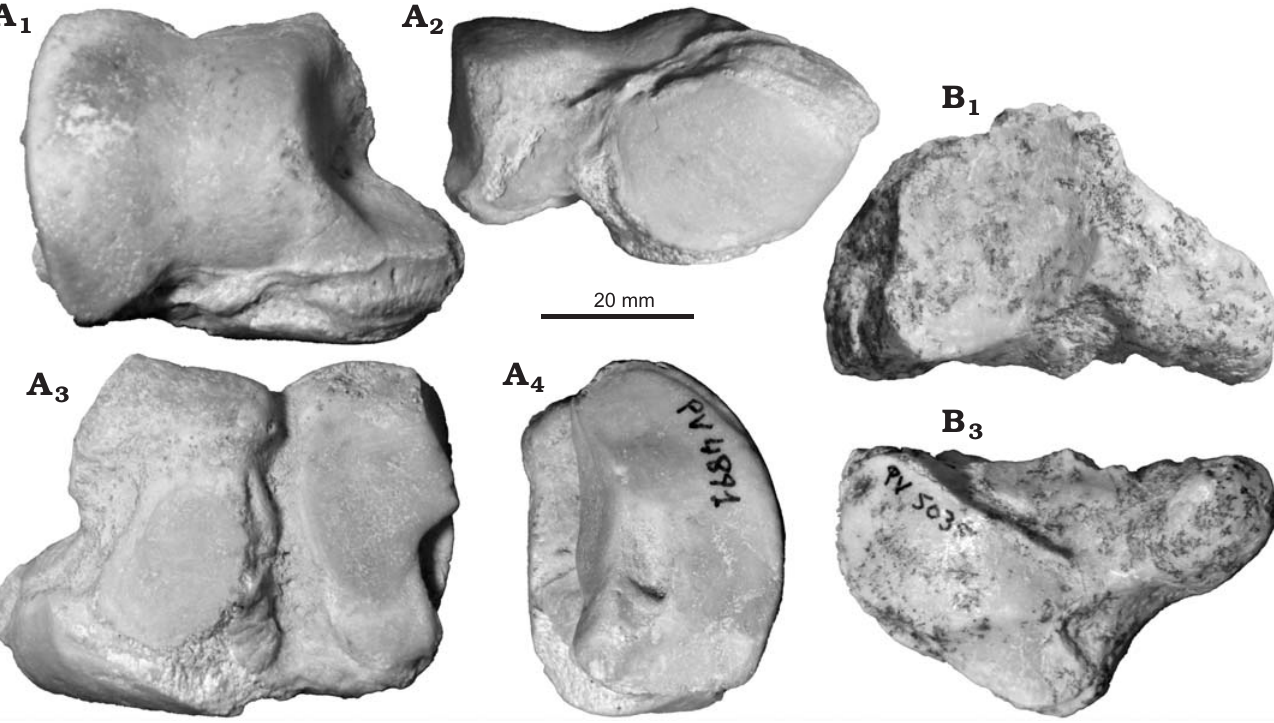
Fig. 6. Tarsal bones of leontiniid notoungulate Gualta cuyana Cerdeño and Vera, 2015 from Quebrada Fiera, Mendoza, Argentina; Deseadan SALMA (late Oligocene). A . MCNAM-PV 4891, right astragalus, anterior (A 1 ), distal (A 2 ), posterior (A 3 ), and lateral (A 4 ) views. B . MCNAM-PV 5035, left navicular, anterior face to the left, proximal (B 1 ) and distal (B 2 )